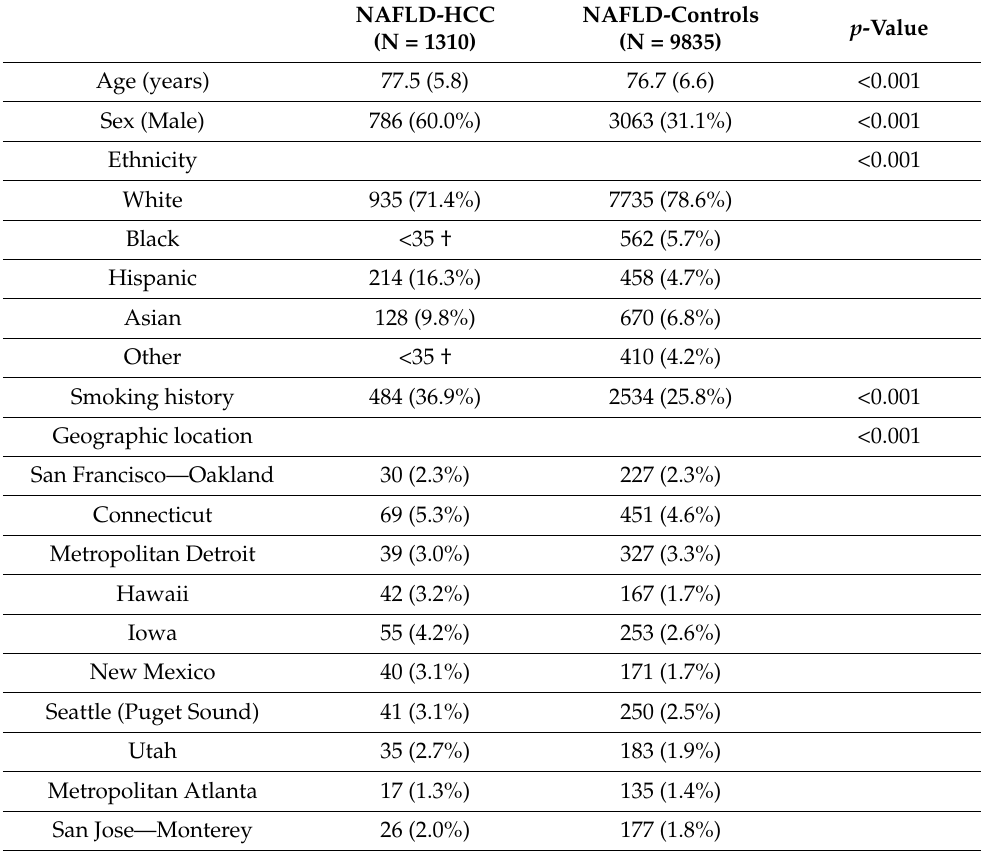
Table 1. Descriptive statistics of study participants (N =